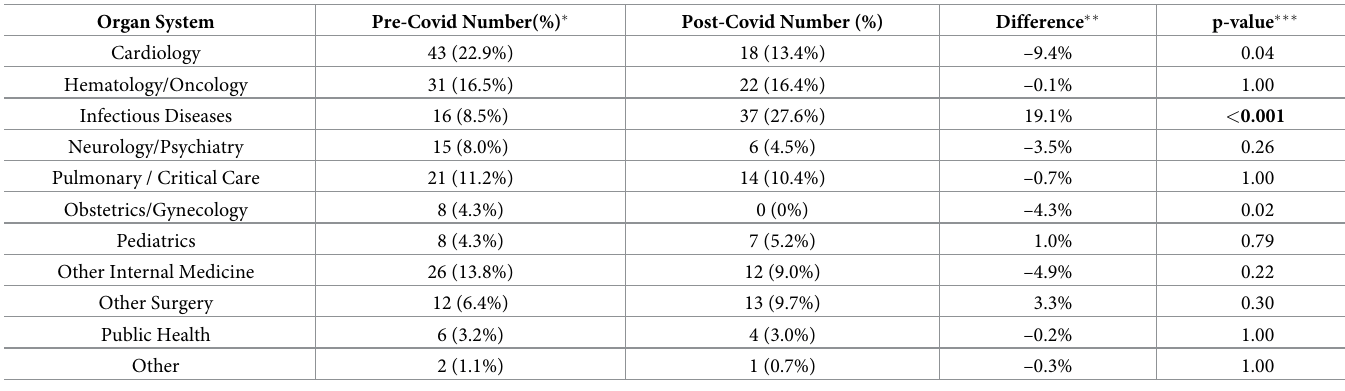
Table 2. Change in full-length research articles pre- and post-Covid-19 by